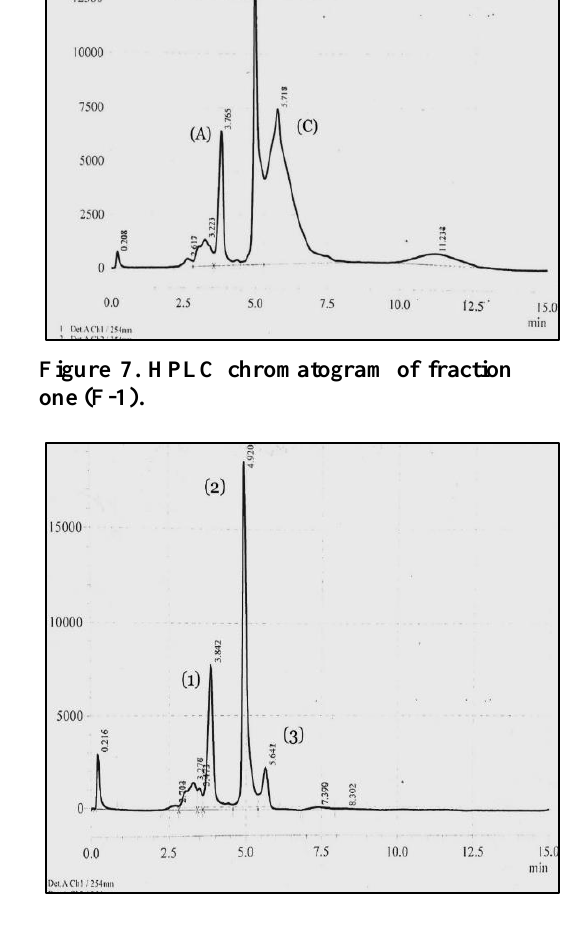
Figure 8. HPLC chromatogram of alkaloid